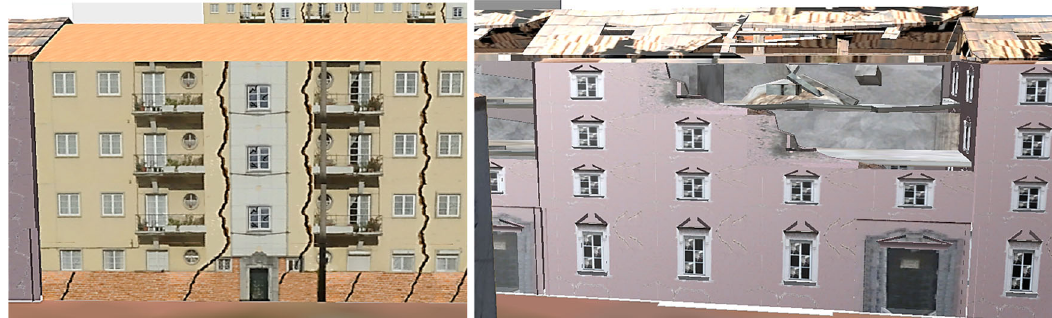
Fig. 11 Models textured according to damage degrees 3 (left) and 4 (right) Fig. 12 Damage realistic scenario—Alvalade, far source,